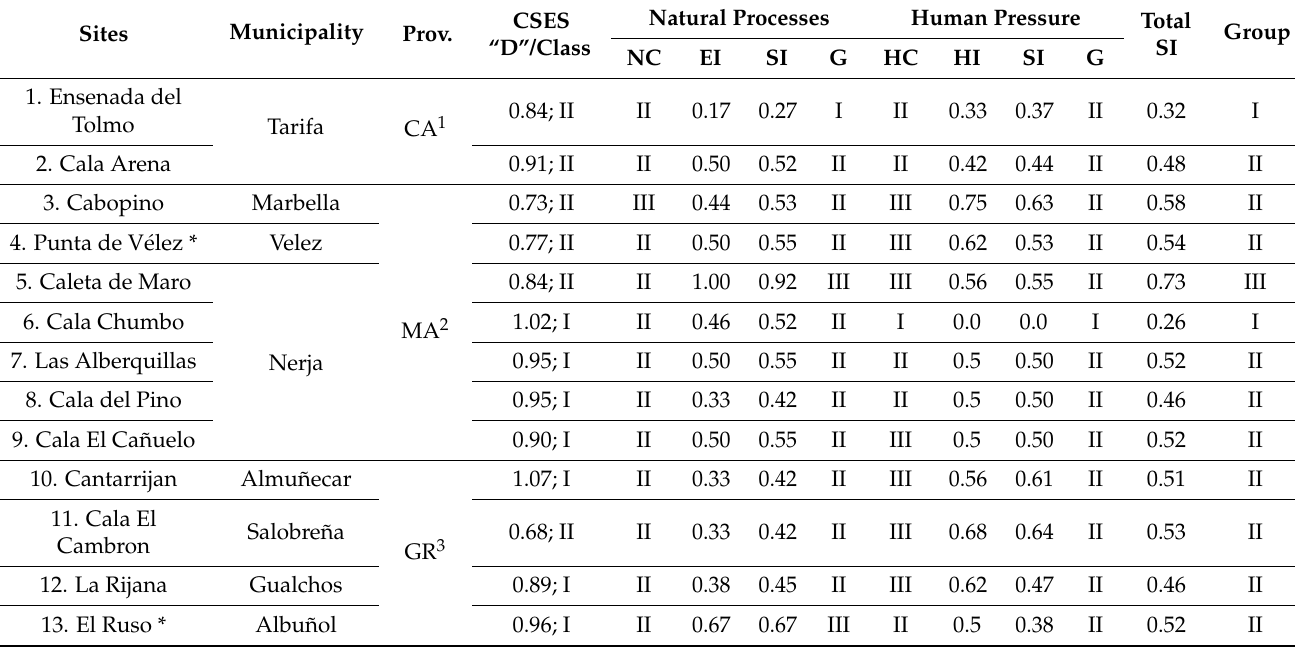
Table 10. Main characteristics of sites studies in the Andalusia Mediterranean coast (Spain) classified by municipalities and provinces: CSES indexes (D), natural and human categories (NC, HC), Erodibility and Human Impact Index (EI, HI), sensitive groups (G) and Sensitivity Indexes